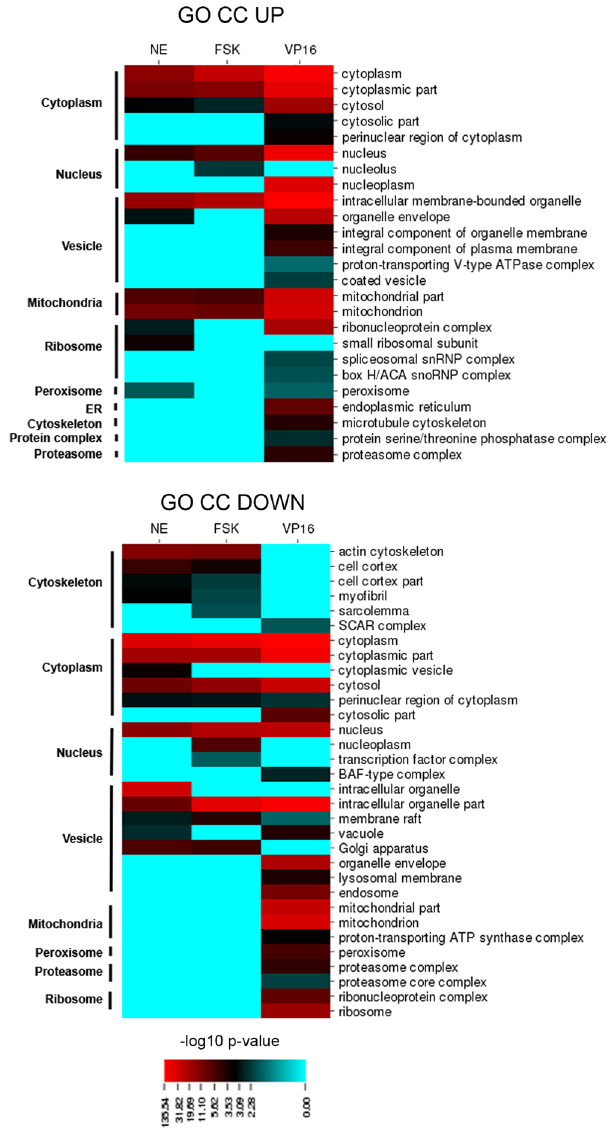
Figure 5. Functional enrichment analysis with GO Cellular Compartment. Heatmaps show -log 10 p- values for each enriched GO Cellular Compartment (CC) term (described in the right) in the pair-wise comparisons NE-CT; FSK-CT; VP16-Null. GOs were manually grouped into larger categories (left) for better understanding of functional changes among conditions. p- values correspond to an enrichment/depletion two-sided hypergeometric statistical test, corrected for multiple comparisons by Bonferroni